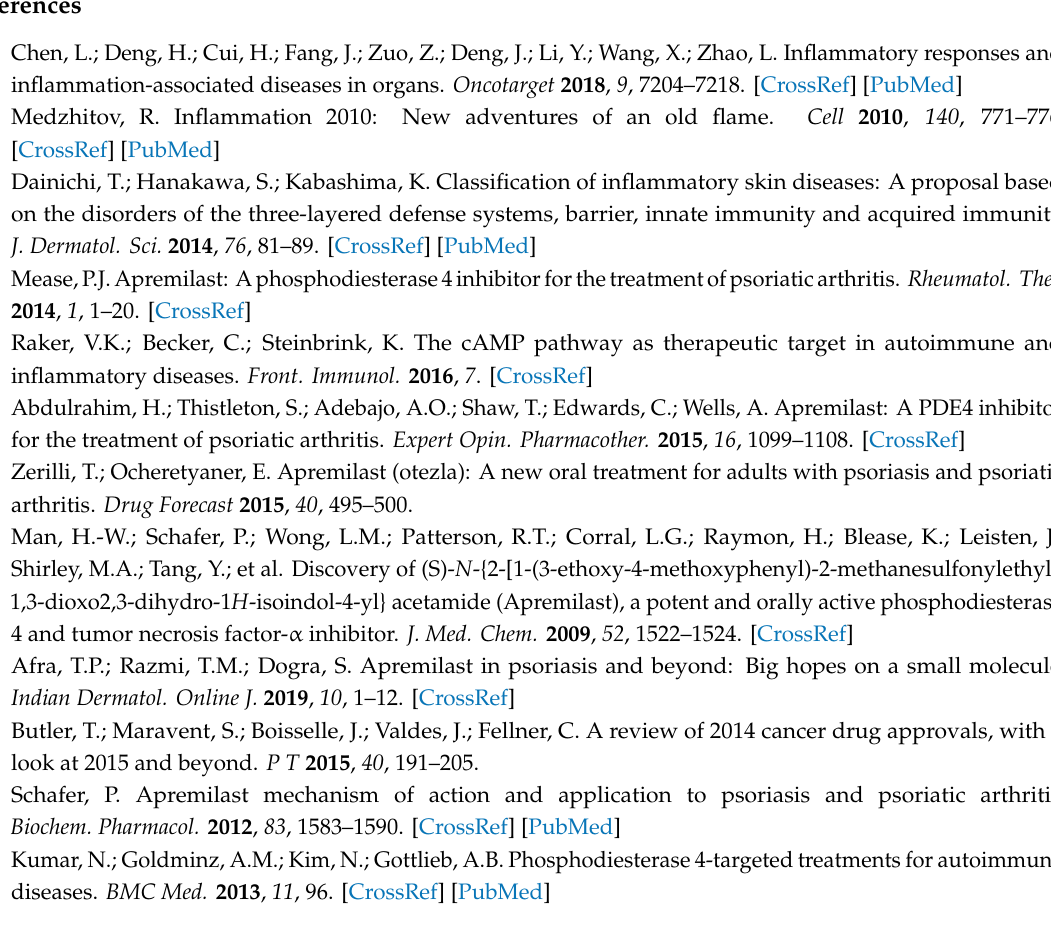
Figure S1: Linearity of the average of 3 calibrate curve; Figure S2: Apremilast chromatograms by HPLC; Figure S3: Rheogram of apremilast microemulsion (APR-ME) showing flow and viscosity curves at 25 ◦ C; Figure S4: Transmission profiles of apremilast microemulsion after 1, 30, 60 and 90 days of production; Table S1: Standards of APR to analyze the linearity; Table S2: Precision inter-day; Table S3: Accuracy of the analytical method; Table S4: Robustness of the analytical method; and Table S5: Limit of detection (LOD) and limit of quantification (LOQ) of the analytical